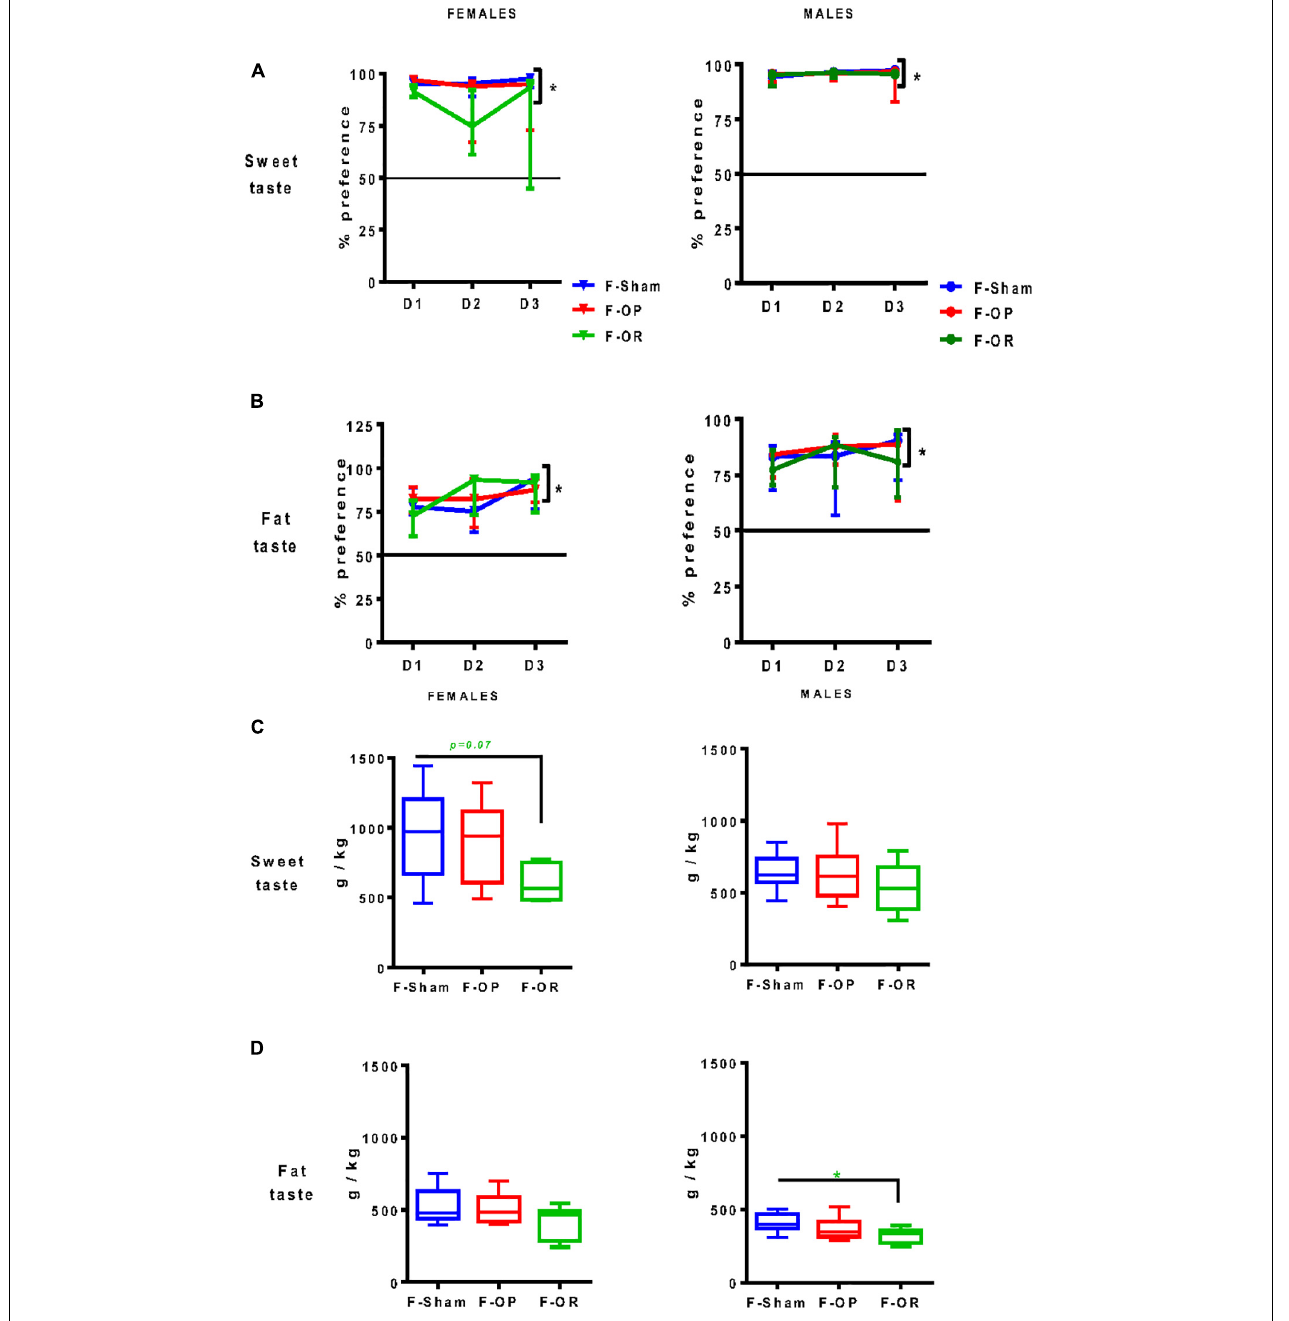
FIGURE 7 | Liquid taste preference. Preference for sweet (A) and fat (B) tastes and total intake of liquids drunk during the 3-day test for sweet (C) and fat (D) tastes in females (left, n = 7–9) and males (right, n = 8–11). Data are expressed as medians and interquartile range. (A,B) * p < 0.05, indicates difference from 50%, Wilcoxon signed rank test. Differences between groups were characterized by Kruskal–Wallis and post hoc Dunn’s at each day of the test. (C,D) * p < 0.05, Kruskal–Wallis and post hoc Dunn’s test. Animals were 75–85-day old and fed